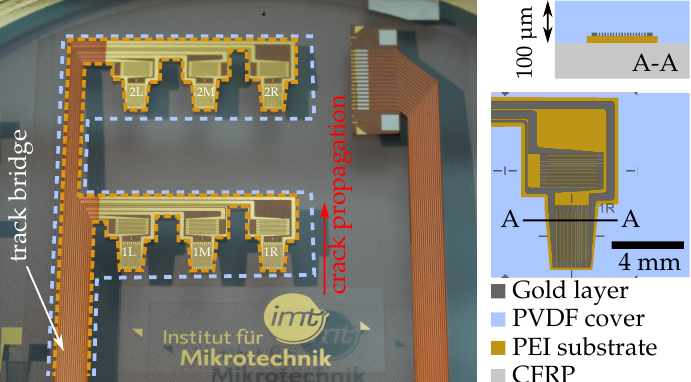
Figure 4. Smart Inlay (still on carrier wafer) with PEI-reinforced two-strip arrangement of sensors. To emphasize the shape of both polymer layers they are surrounded by an orange dotted line (for PEI) and a white dotted contour (for PVDF). Crack propagation direction towards the inlay is indicated in red. Sensor positions in row 1 and 2 are additionally marked L (left), M (middle), and R (right). The labeled track bridge forwards all electrical signals. Right: Schematics are showing the geometry of the sensors in cross-sectional and top